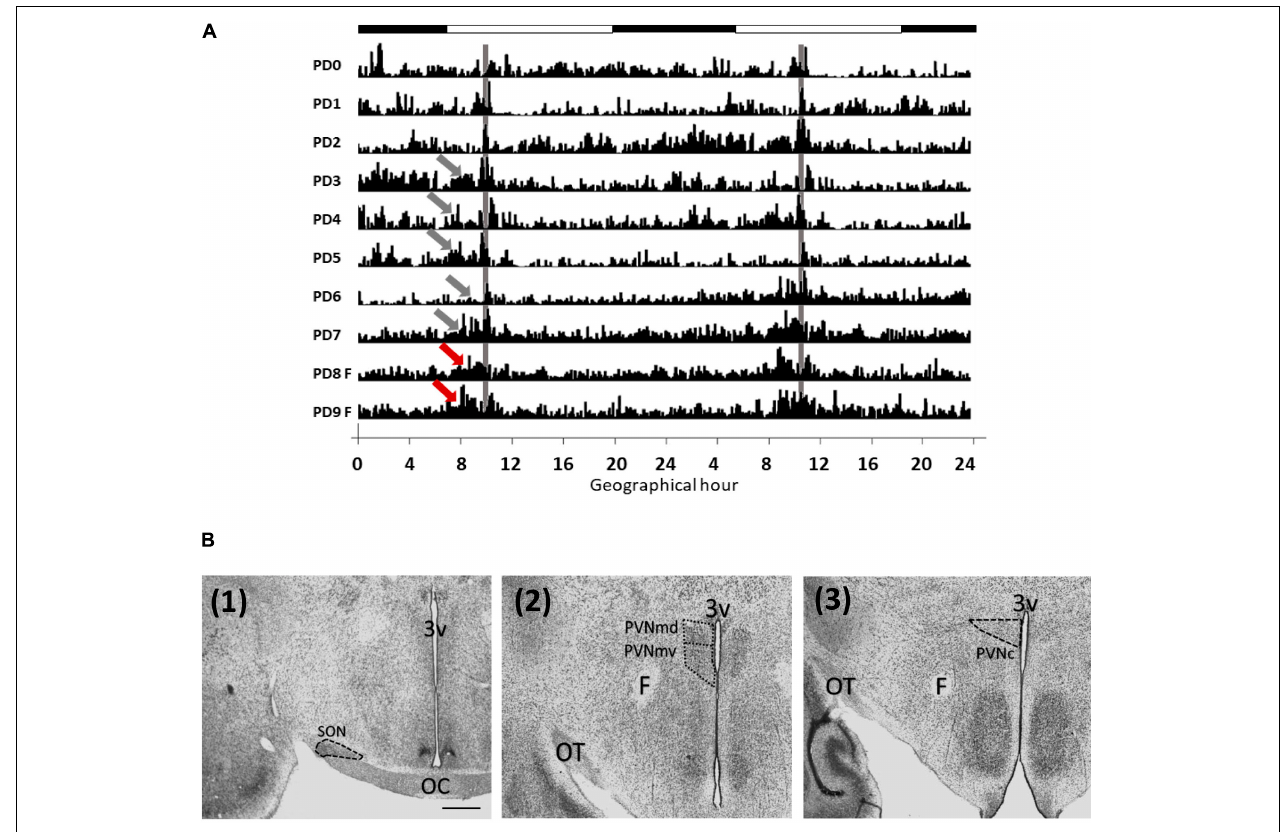
FIGURE 1 | Locomotor activity of rabbits from postnatal days 1 to 9 (A) and analyzed areas (B) . (A) Double plotted actogram from a representative litter. Intensity of activity is represented by black vertical lines. Pups increase their activity (gray arrows) before nursing time (gray vertical line), at PD8 and PD9 the doe was not permitted to nurse but locomotor behavior increased again at the previous scheduled time of nursing (red arrows). Each horizontal line represents a postnatal day. Black and white bar at top represents light/dark cycle of the mother. (B) Photomicrographs (Thionin stain) showing the location of the SON (1), PVNmd and PVNmv (2) and PVNc (3). 3v, third ventricle, OC, optic chiasma; OT, optic tract; F, fornix; Scale bar: 500 µ